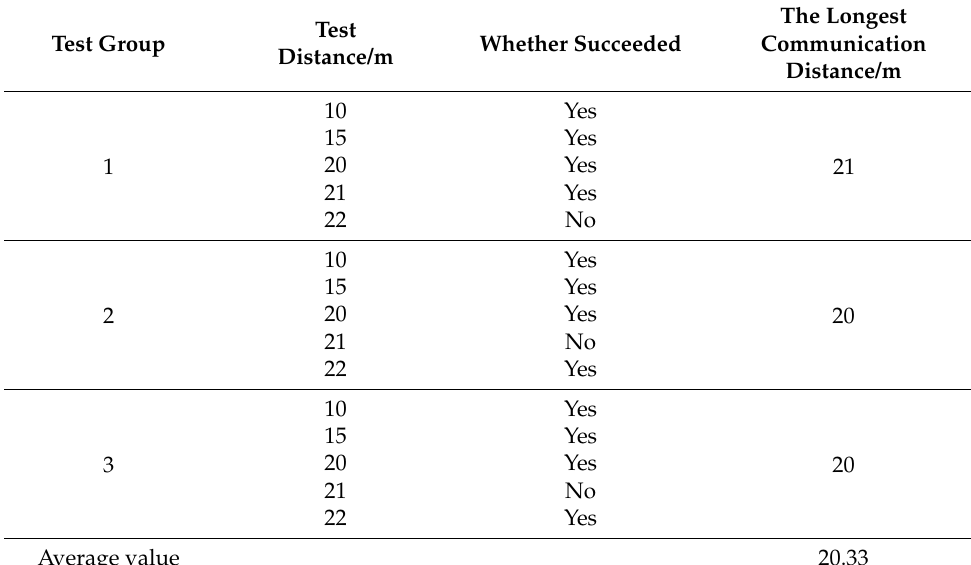
Table 8. The longest communication distance test.